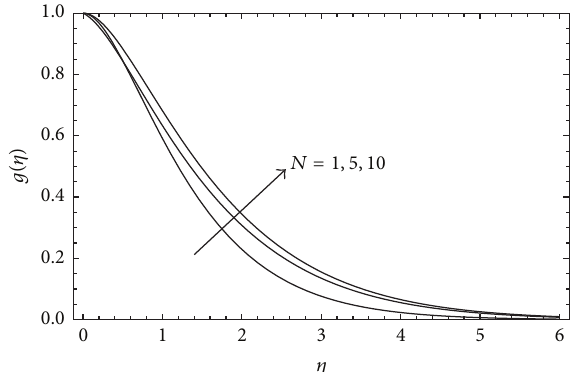
Figure 10: Variation of temperature profiles with Pr for 𝑀 = 𝑁 = 1 and 𝐾 𝑤 = 2 .